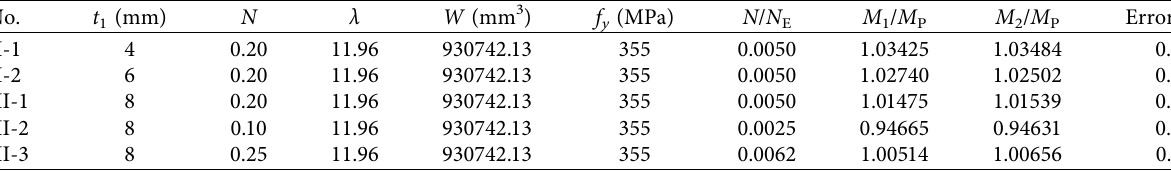
Table 6: Design parameters and resulted capacity of specimens.